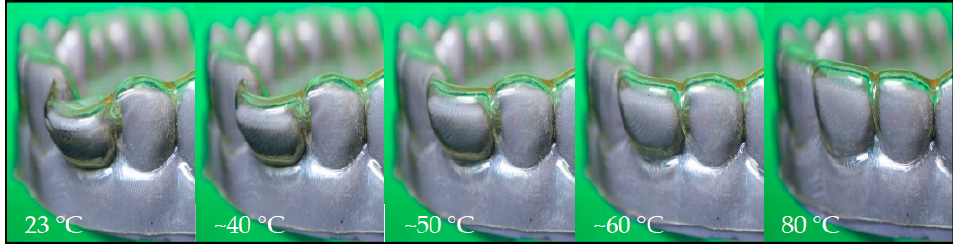
Figure 7. Heating-induced movement of a loose incisor from misaligned to its ideal position as enabled with a TPU aligner by the thermally triggered SME. The temperature gradually increased from 23 °C (left) to 80 °C (right).